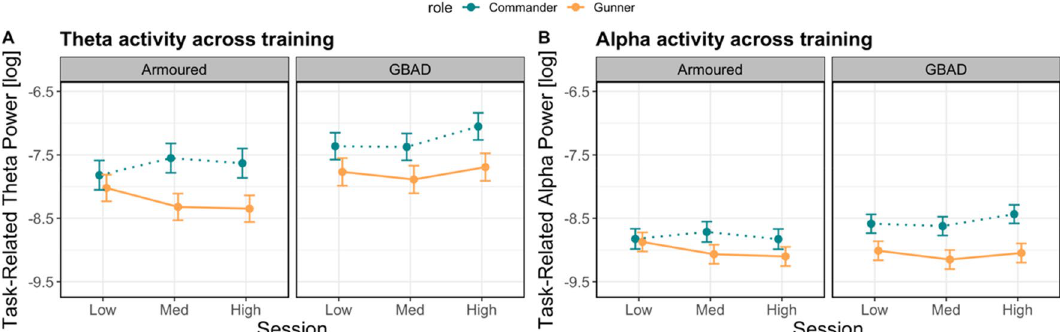
Figure 2. Modelled effects of task-related neural activity. ( A ) Theta power (y-axis; higher values indicate increased power) across scenario one (Low), two (Med) and three (High; x-axis) between Armoured (left) and GBAD (right). Estimates from commanders are represented by the dashed blue line, while estimates from gunners are represented by the solid orange line. Error bars represent the 83% confidence interval. ( B ) illustrates the same as ( A ) but for alpha power.